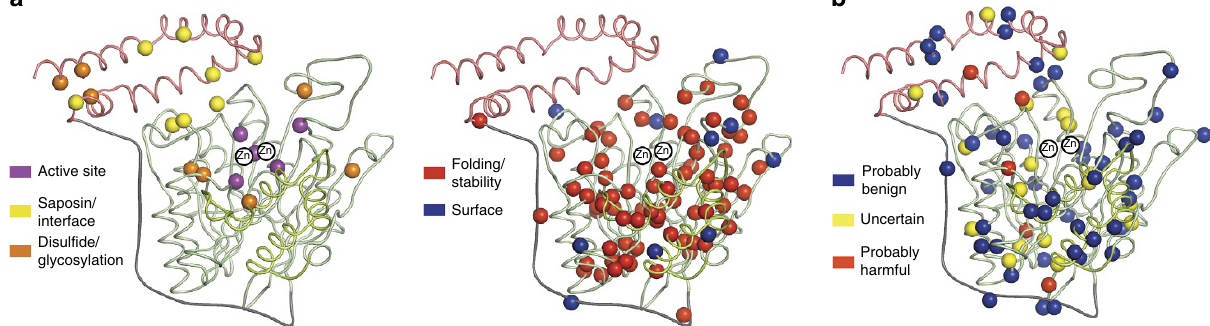
Figure 7 | Structural mapping of disease mutations. ( a ) Mapping of Niemann–Pick mutations on ASMase. Mutations are indicated by spheres coloured according to their predicted effect. ( b ) Locations of additional ASMase variants of unknown